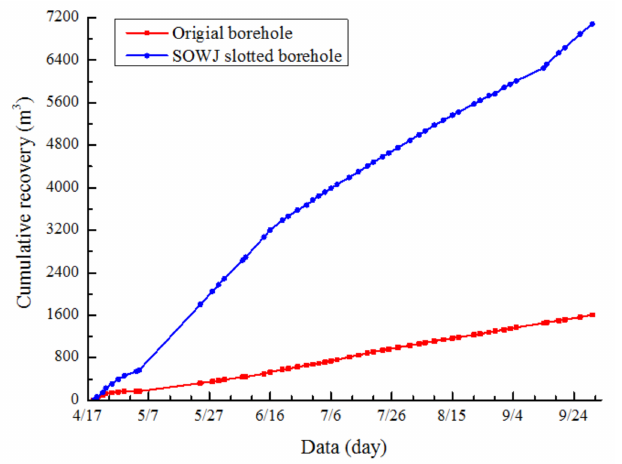
Figure 20. Accumulative gas extractions of standard and SOWJ slotting